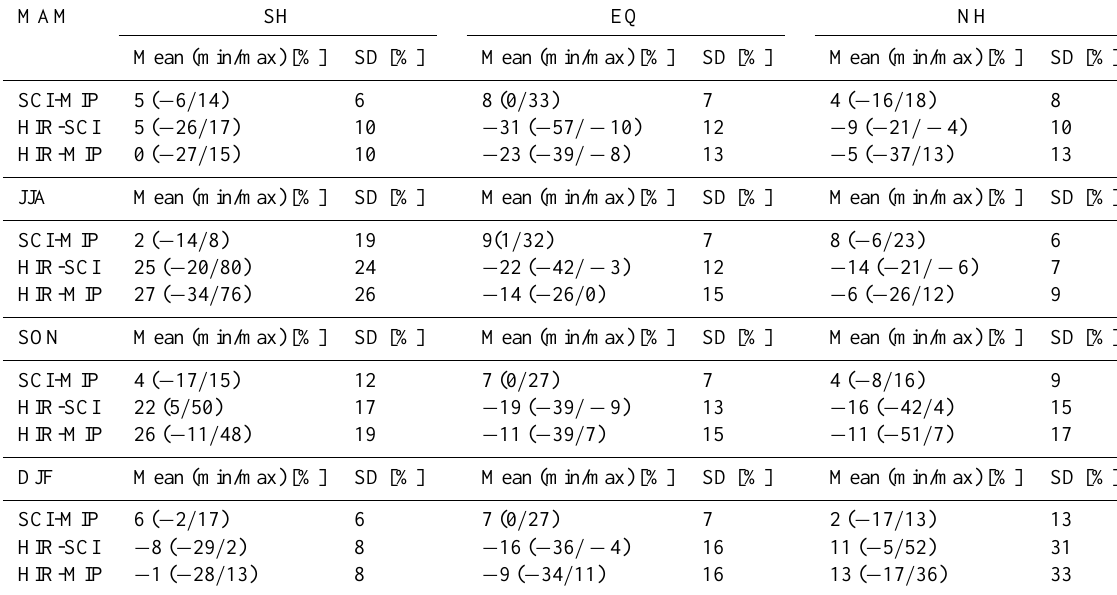
Table 2. Comparison statistics (MRD and SD) over 5–50hPa (extratropics) and 3–30hPa